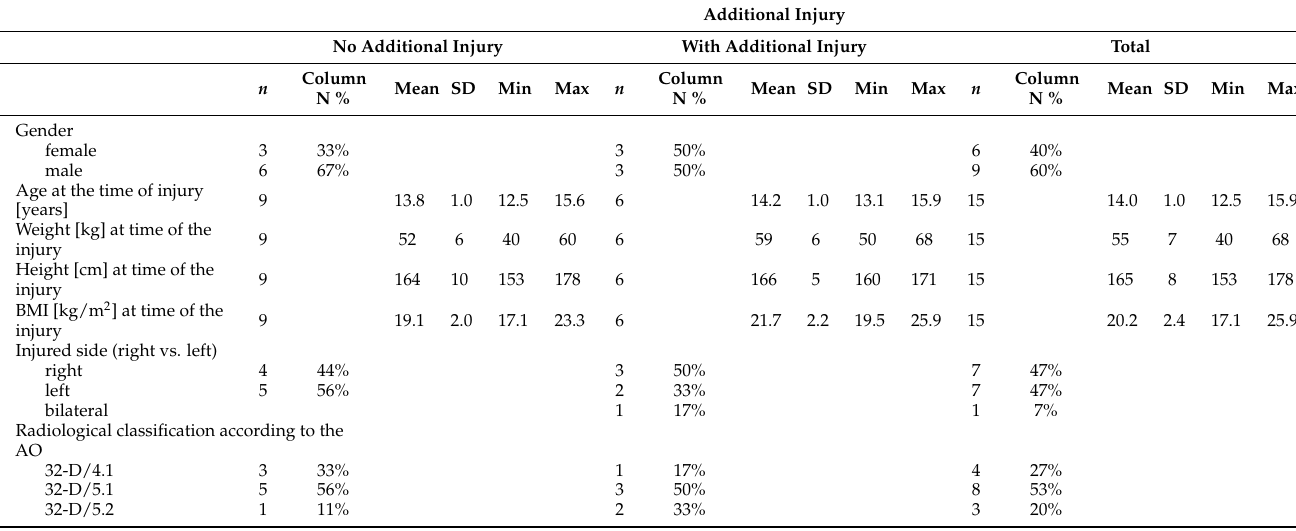
Table 1. Baseline characteristics by additional